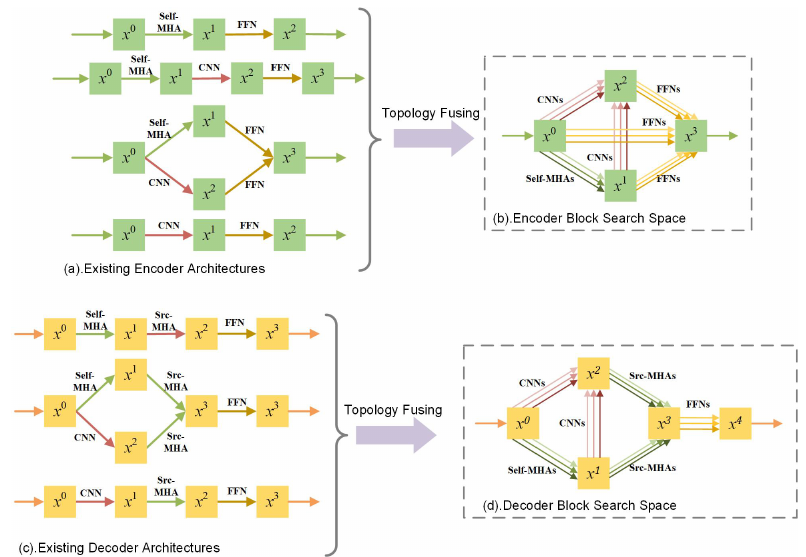
Figure 2. ( a ) is four human-designed encoder architectures. ( b ) is our topology-fused encoder search space. ( c ) is three human-designed decoder architectures. ( d ) is our topology-fused decoder search